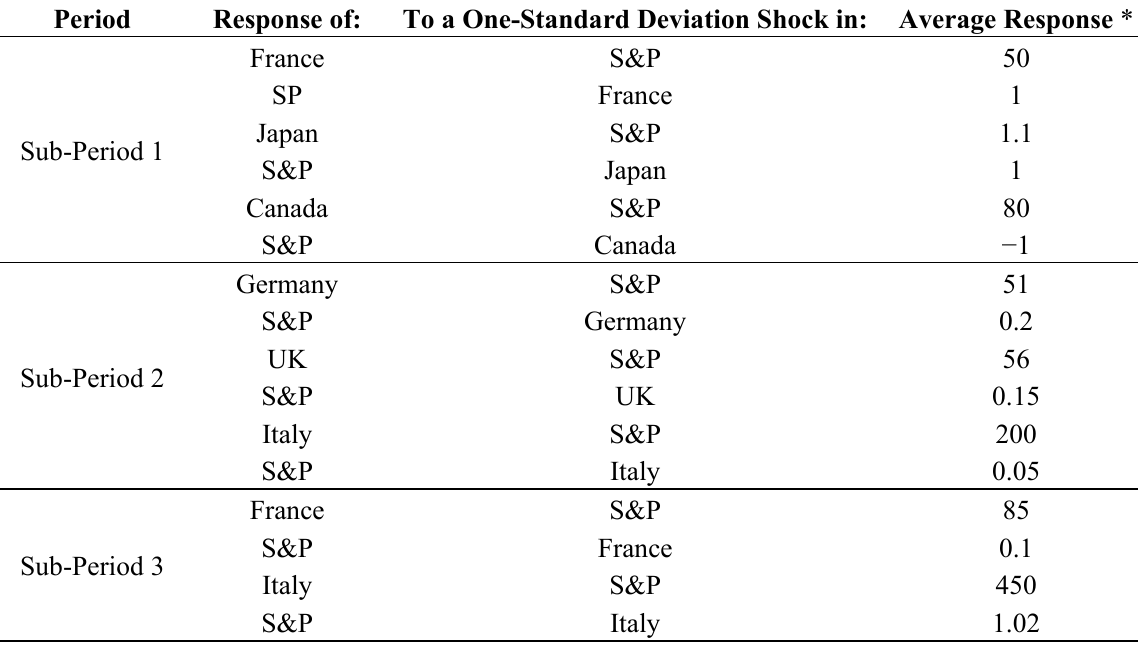
Table 4. Impulse Response